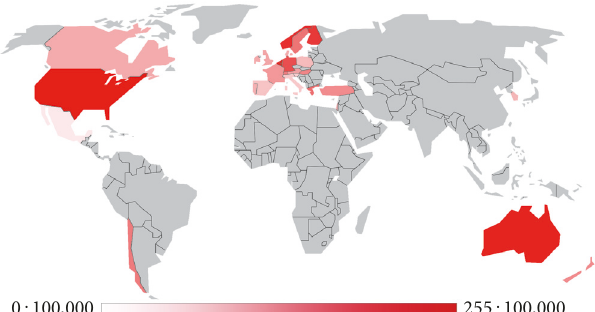
Figure 1: Tonsillectomies performed per 100,000 residents in the member countries of the OECD (mean: 128: 100,000; median: 113: 100,000; data originated between 2006 and